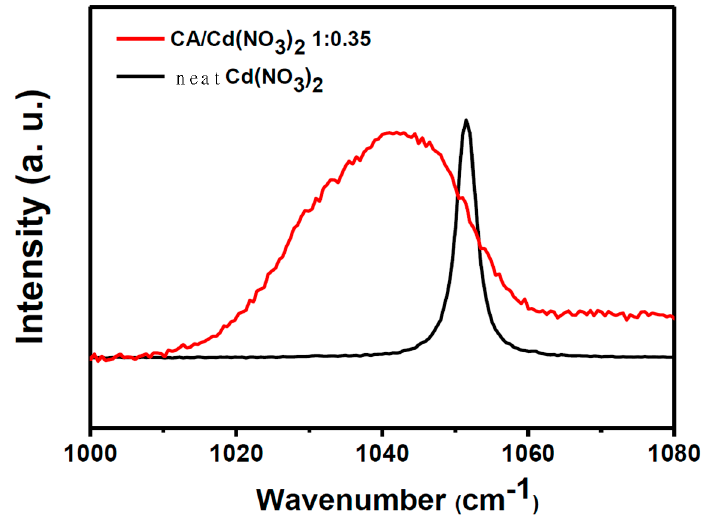
Figure 5. Raman spectra of neat Cd(NO 3 ) 2 ·4H 2 O and CA/Cd(NO 3 ) 2 ·4H 2 O polymer matrix.